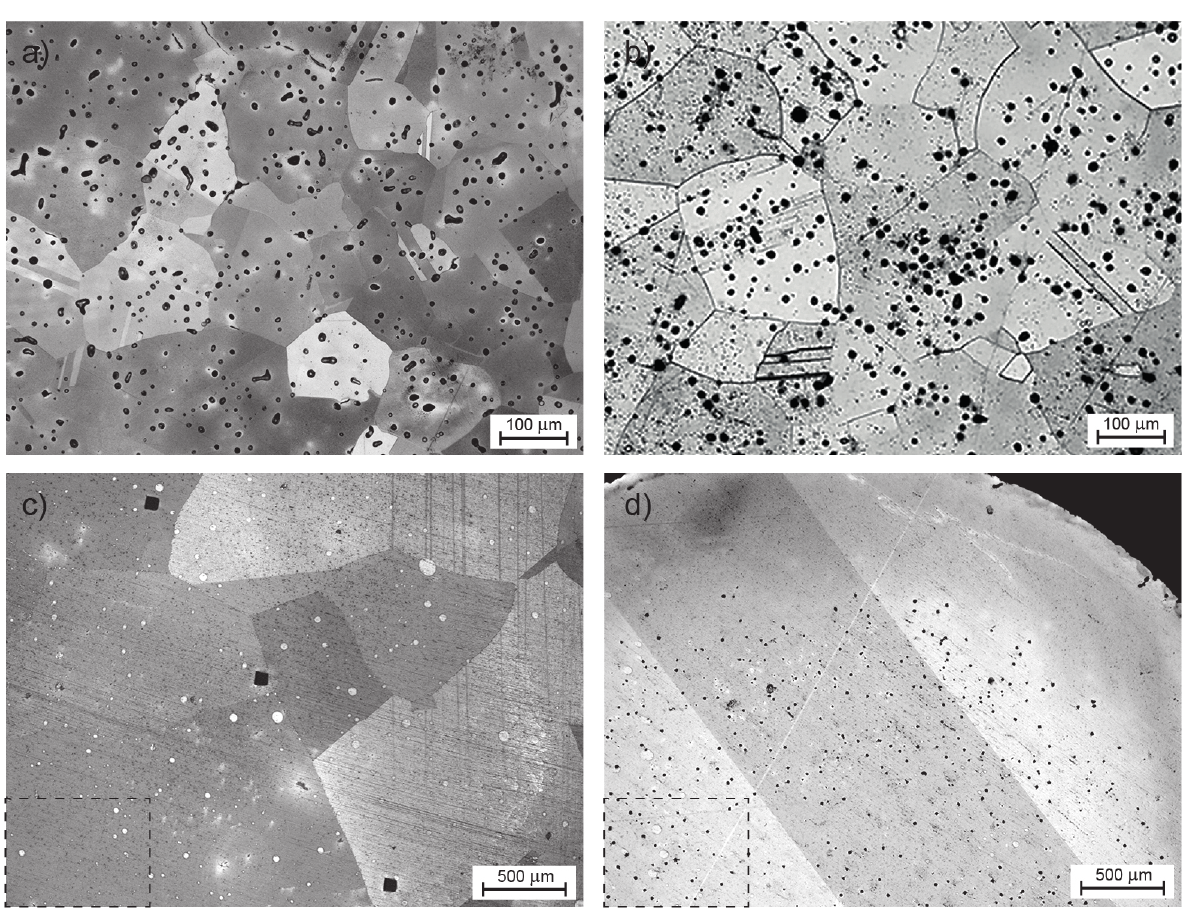
Figure 4. Micrographs of samples sintered in N 2 -5%H 2 at 1325 °C during ( a ) 4 h of plateau, ( b ) 12 h of plateau, ( c ) 4 h of plateau and HIP treatment and ( d ) 12 h of plateau and HIP treatment. The enclosed area in dashed lines illustrates the area equivalent to that magnified for samples without